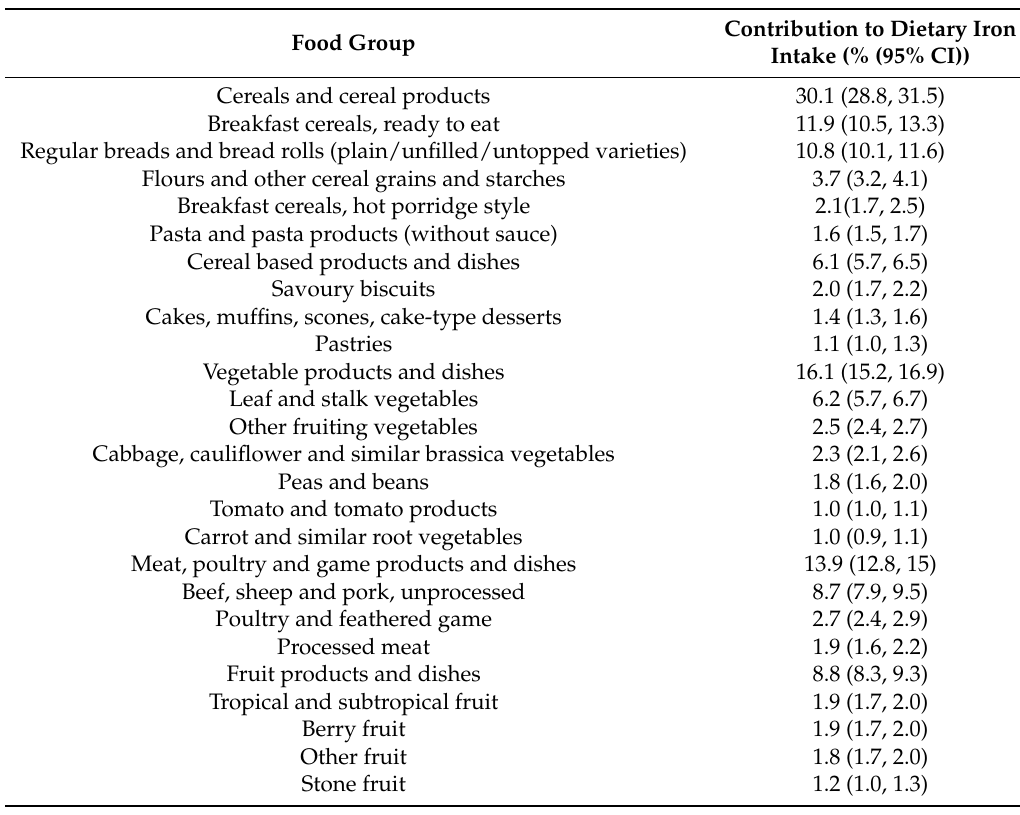
Table 2. Contribution of foods to dietary iron intake among the study group of women aged 18–50 years a,b